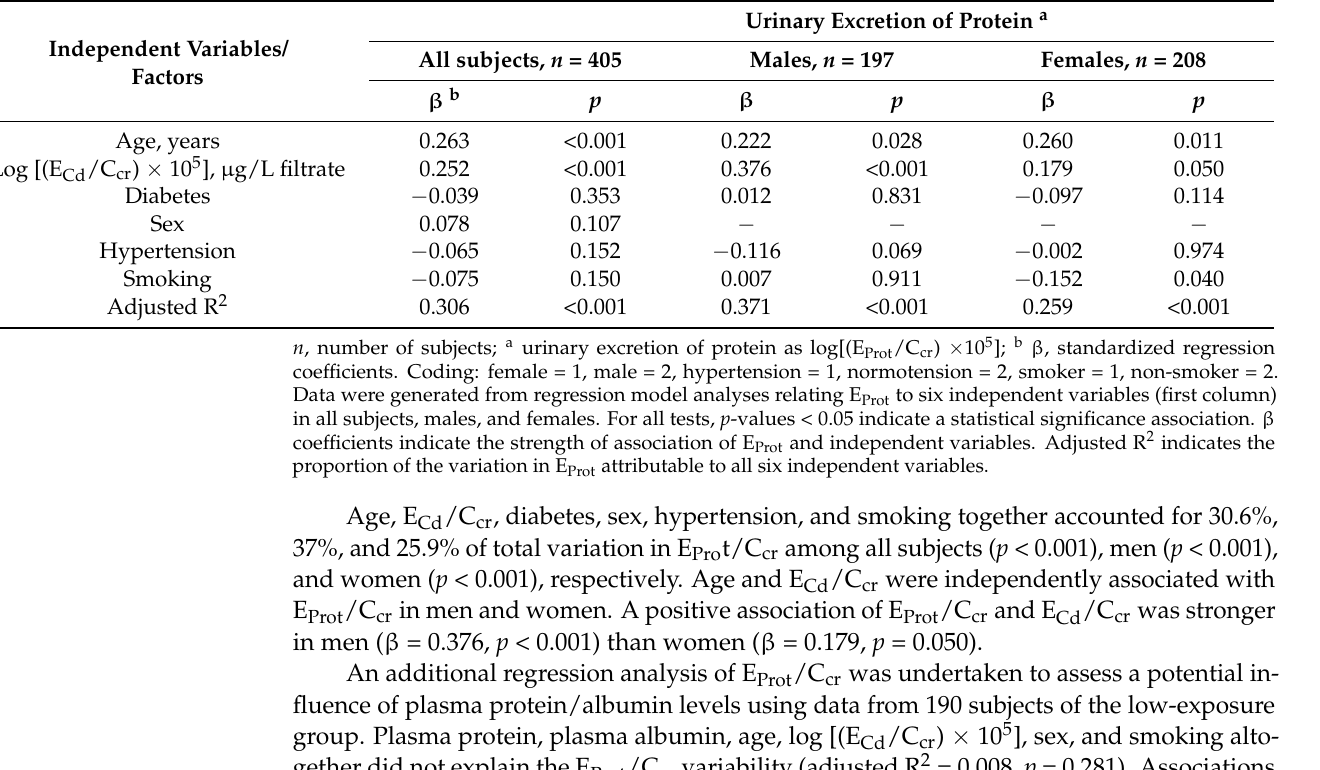
Table 2. Multiple regression analyses to evaluate strength of association of log[(E Prot /Ccr × 10 5 ) with log log[(E Cd /Ccr × 10 5 ) and other independent variables.